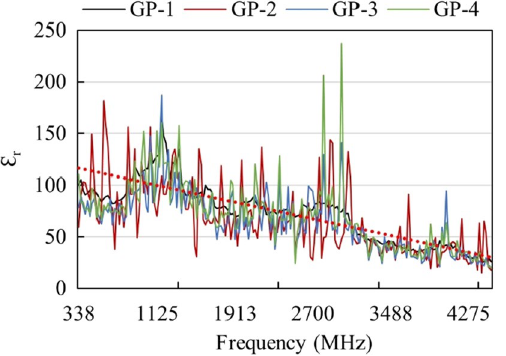
Figure 12. Dielectric properties of the synthesized geopolymer composites.